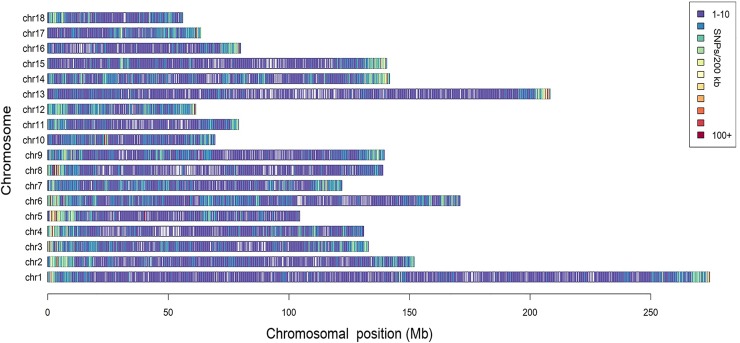
Distribution of the SNPs across the chromosomes. The x-axis denotes the chromosomal position (Mb), and the y-axis represents the chromosomes. The number of the SNPs present in each 200 kb genome block is expressed via colors.